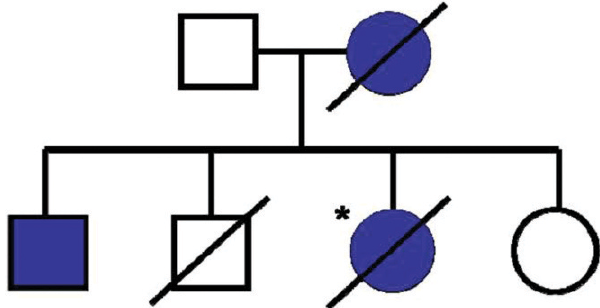
Figure 2 - Pedigree of the family. Square=male member, circle=female member; solid symbol=pneumothorax, open symbol=no pneumothorax; slash through symbol=cystic lesions on lung CT; * our